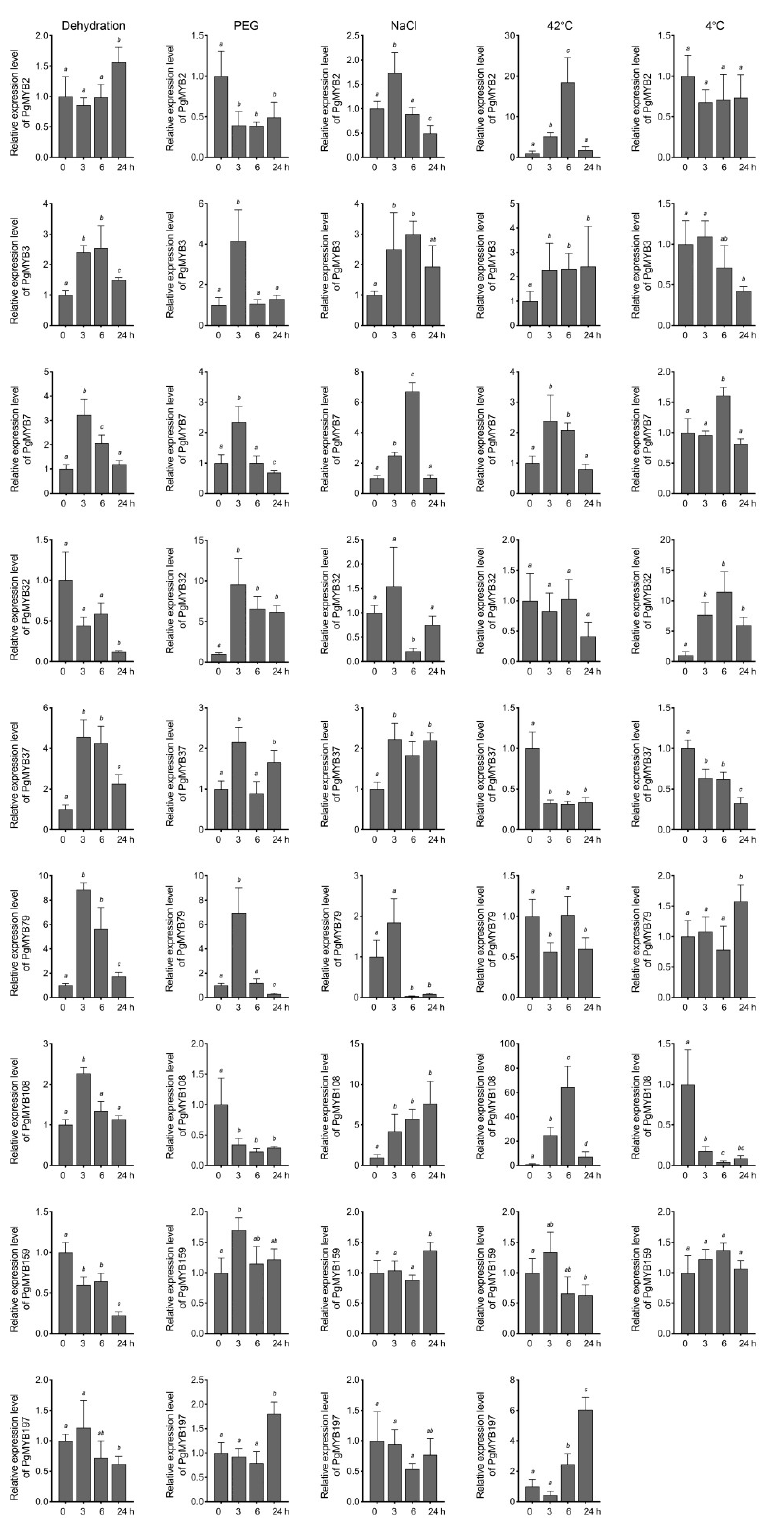
Figure 7. Expression analysis of nine R2R3-type PgMYB genes in response to different abiotic stresses. Three-week-old hydroponically grown seedlings were stressed as described in Materials and Methods. Shoot tissues were harvested at each indicated time point. Expression level of each PgMYB gene at 0 h is set as control. The expression of PgMYB197 gene was not detected under cold stress. The data represent the mean values of three replicates ± SD. Statistical significance of differences was tested by one-way ANOVA analysis ( p < 0.05) and is indicated by lower case